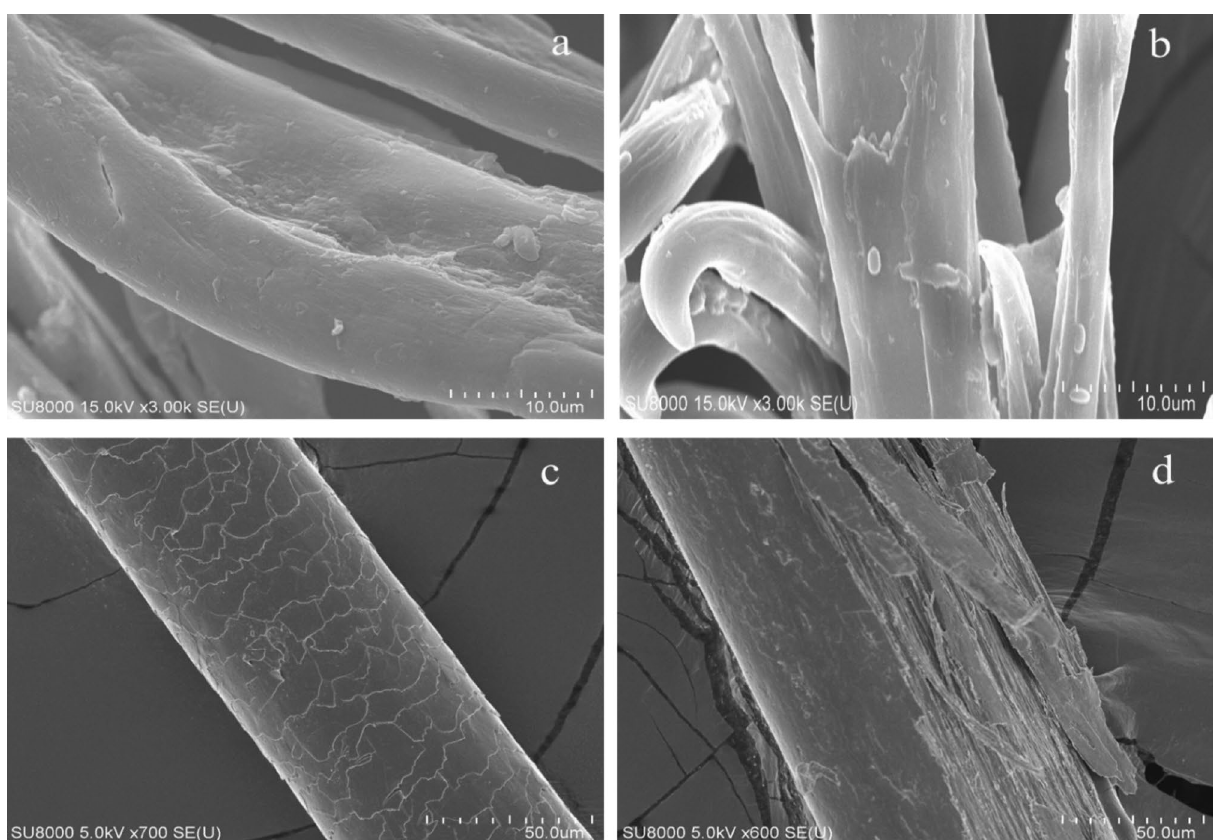
Figure 5. SEM images. ( a ) Control chicken feather, ( b ) Degraded chicken feather by treatment with SLSP-k incubated for 48 h at 50 °C, ( c ) Control human hair, ( d ) Degraded human hair by SLSP-k incubated for 72 h at 50